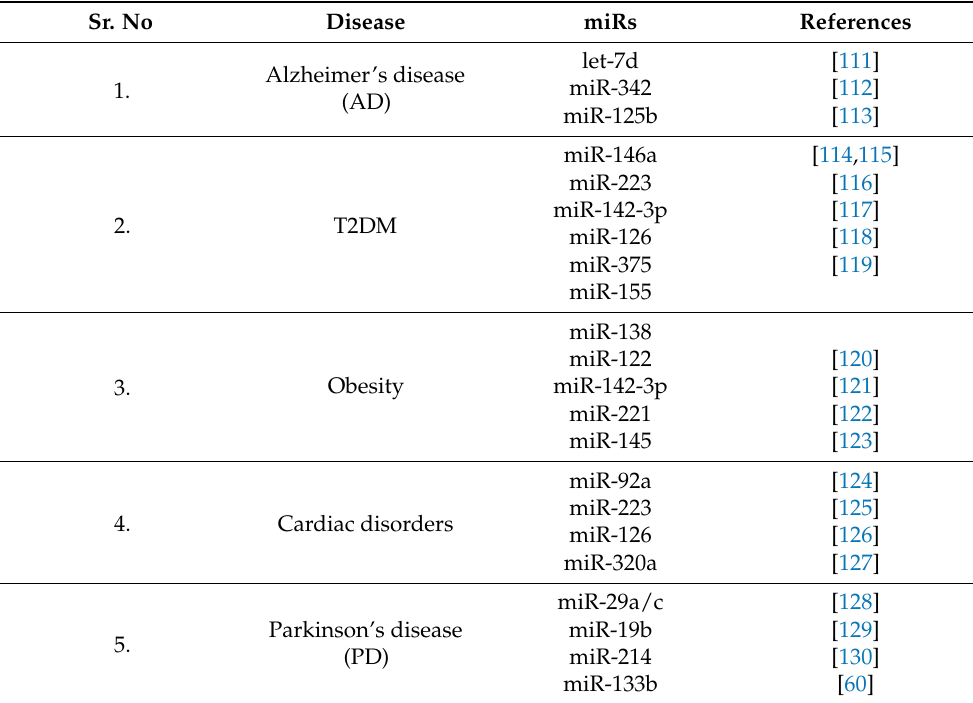
Table 1. miRs expression in various inflammatory diseases. Sr. No Disease